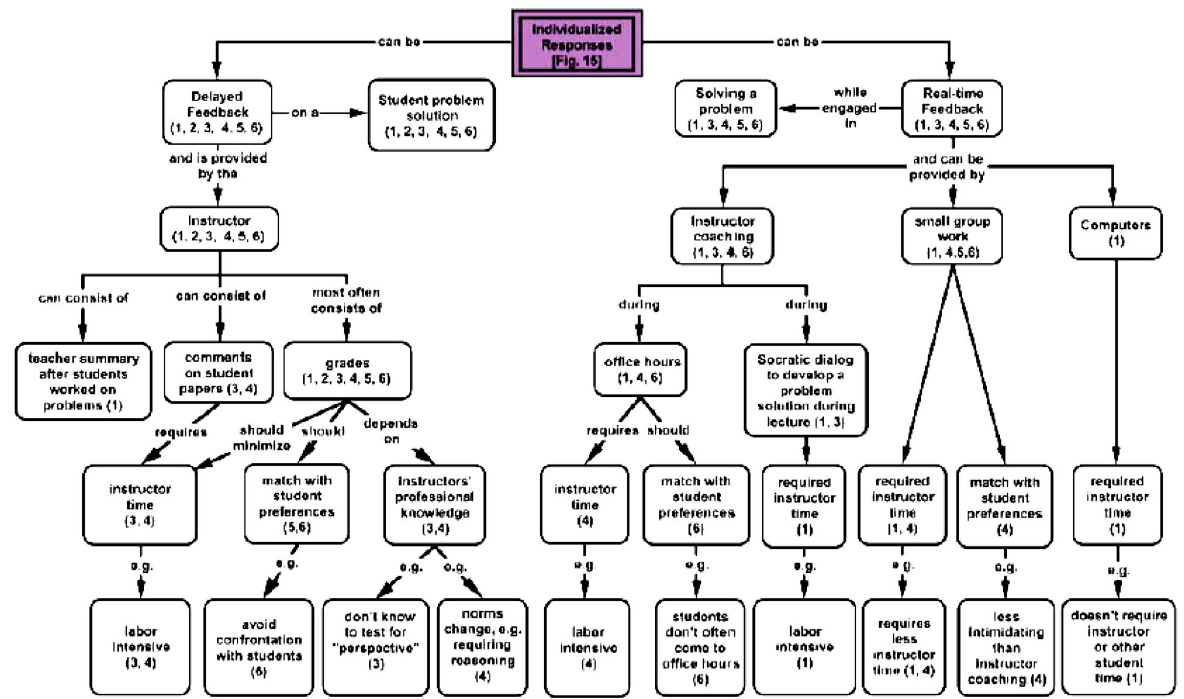
FIG. 15. (cid:1) Color (cid:2) Constraints part of composite map “Individualized response” concerned with faculty beliefs about the appropriate structure of individualized response in their introductory physics course. Numbers in the parentheses denote the instructor whose statements directly justify that